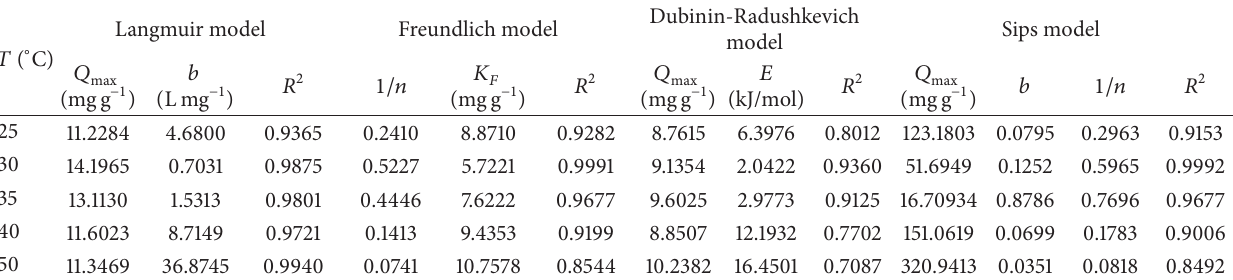
Table 4: The isotherms parameters for methylene blue adsorption onto AC2.